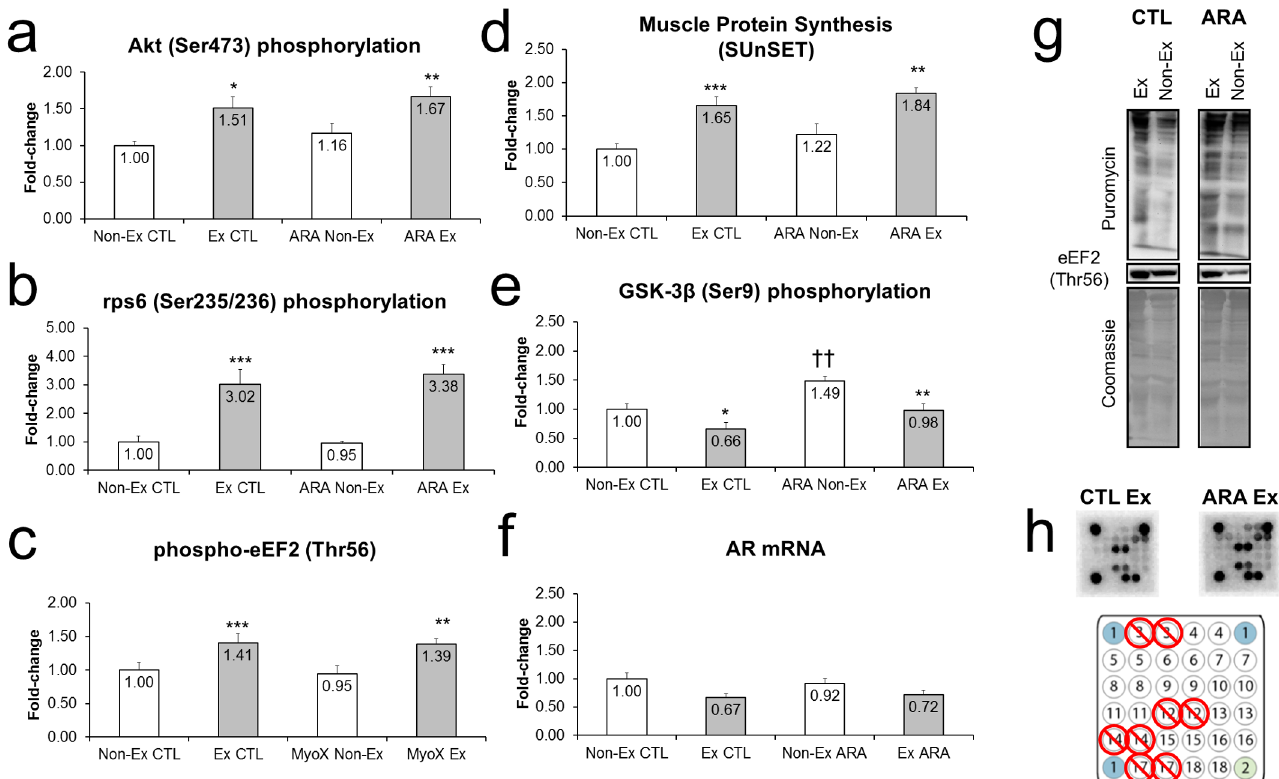
Fig 3. Fold-change values for Akt (Ser473) phosphorylation (a), rps6 (Ser235/236) phosphorylation (b), eF2 (Thr56) phosphorylation (c), and AR mRNA expression (f) in non-exercised (open bars) and exercised (closed bars) rodents with (right) or without arachidonic acid supplementation. Representative digital images for MPS levels and eF2 phosphorylation levels, as well as Coomassie images to verify equal protein between lands (panel g). Note that some targets were not included in the analyses due to poor and/or inconsistent signal (panel h).